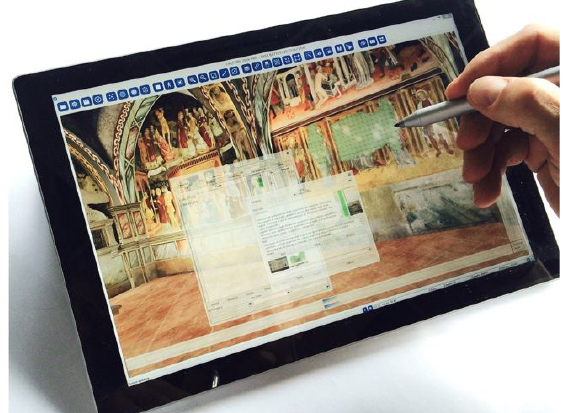
Figure 6. Example of a segmentation process carried out with EasyCUBE PRO tools